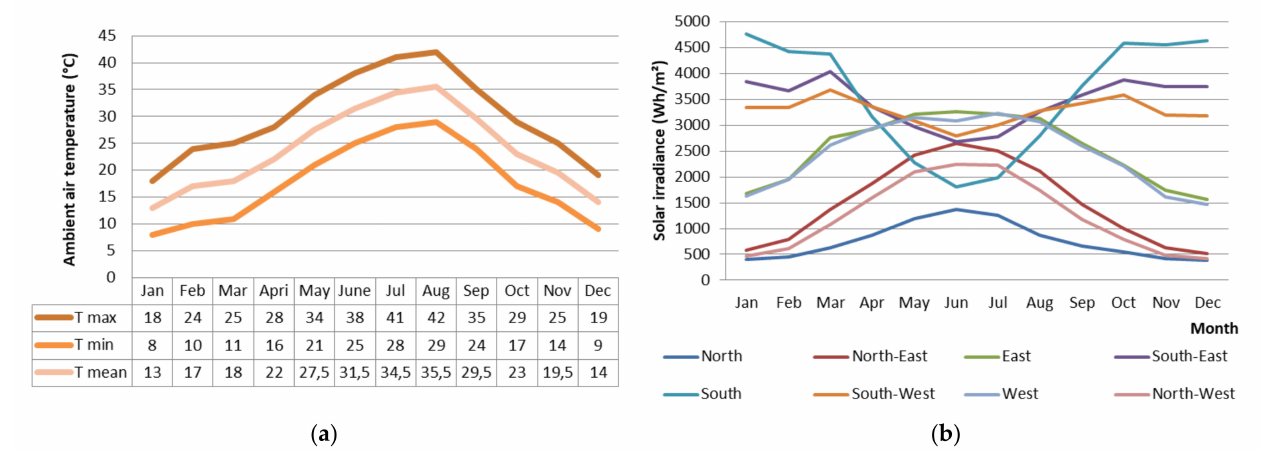
Figure 2. ( a ) Ambient air temperature ( ◦ C). ( b ) Incident global irradiation on a vertical plane.